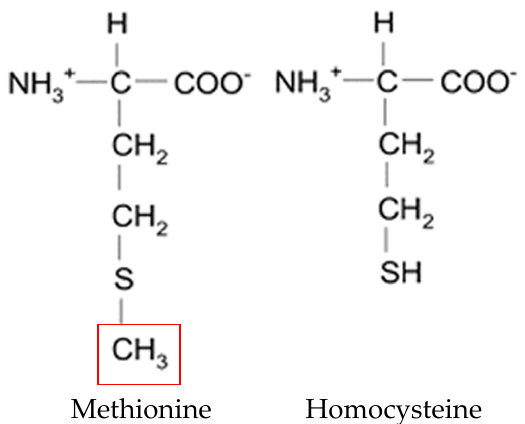
Figure 1. Chemical structure of methionine and homocysteine.